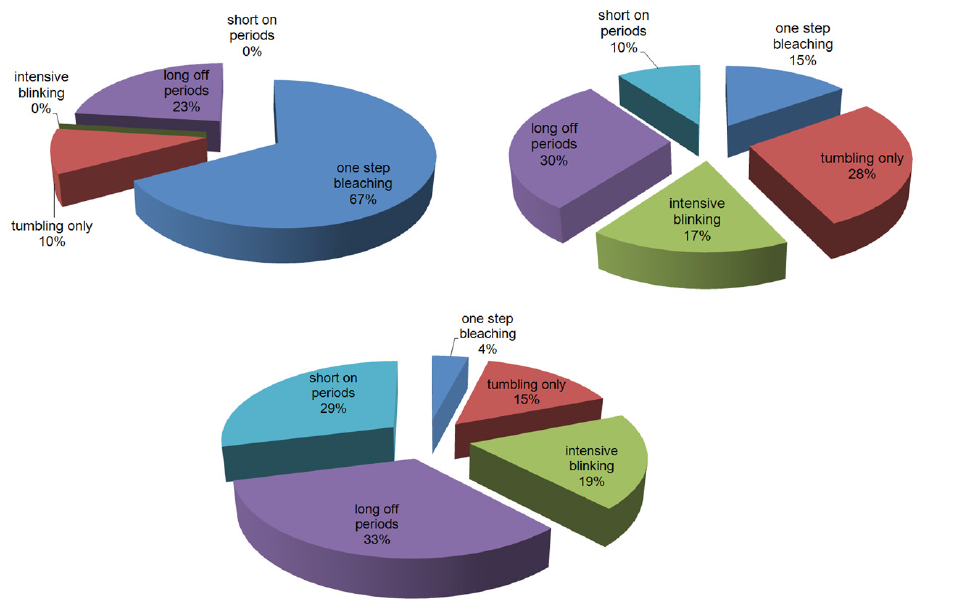
Figure 11. Characterization of the fluorescence time traces of groups of single molecules 1 embedded in pvac matrix and measured at (a) 21°C, (b) 28°C and (c) experiment with slow temperature changes are shown in Fig. 12 . The temperature of the film was decreased from 41°C to about 24°C, crossing the T at 28°C, and then g increased again up to 41°C. Ten images of different areas of the sample were taken at each temperature. Average numbers of fluorescing molecules were obtained after equilibration for about 15 min at each temperature. The error bars show the standard deviation of the average number of molecules at the ten areas.